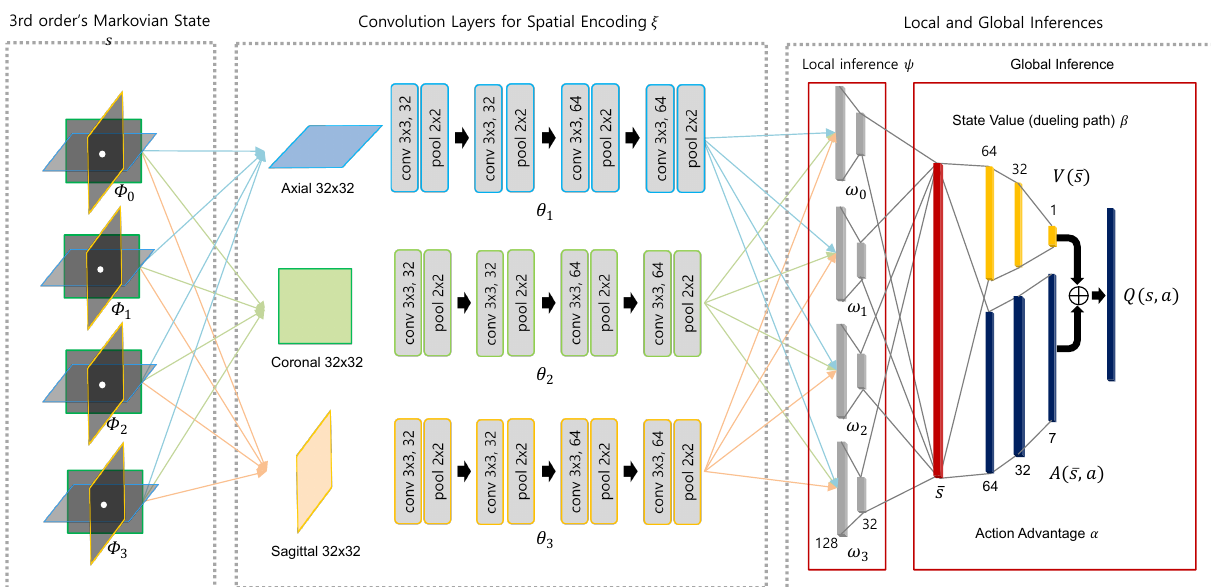
Figure 3. Explicit spatio-sequential encoding network (EsseNet): The four sequential states s and each orthogonal view patch Φ are independently encoded in the convolutional layer ψ . However, convolution parameters θ are shared for the same view despite being observed from different sequences. Features encoded from each view are collected into the corresponding sequence domain, and local inference is applied for each sequence. Finally, all information is concatenated, and the final action values can be obtained by passing through the dueling and action advantage